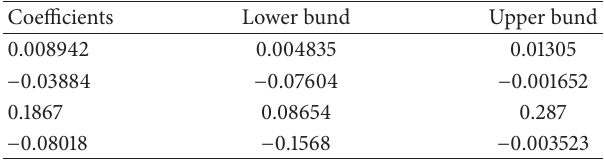
Table 4: 95% confidence interval for estimated coefficient of 𝑓(𝑡 𝑦 ) .